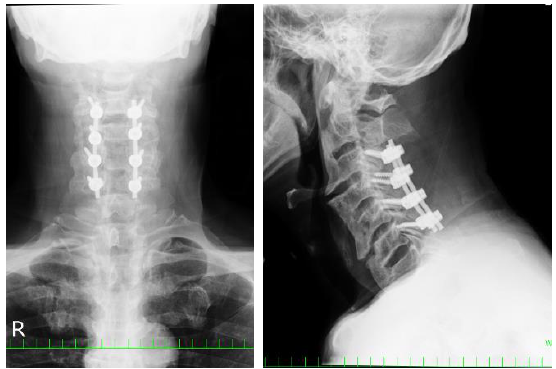
Figure 3. Posterior decompression fixation of the 3rd–6th cervical vertebrae was performed in case 1.